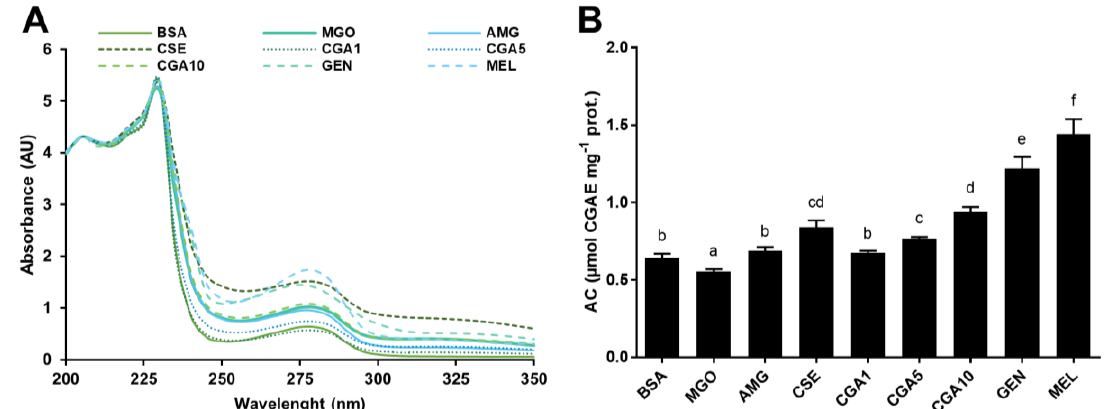
Figure 5. UV-Vis spectra ( A ) and antioxidant capacity ( B ) of the high molecular weight protein fractions (>30 kDa) isolated from the samples of the BSA-MGO glycation system (72 h agitation, 37 °C, pH 7.4) BSA: negative control; MGO: BSA + methylglyoxal; AMG: BSA + methylglyoxal + aminoguanidine; CSE: BSA + methylglyoxal + CSE (12,5 mg mL ‒1 ); CGA1: BSA + methylglyoxal + 1 mmol L ‒1 CGA; CGA5: BSA + methylglyoxal + 5 mmol L ‒1 CGA; CGA10: BSA + methylglyoxal + 10 mmol L ‒1 CGA; GEN: BSA + methylglyoxal + 5 mmol L ‒1 genistein; MEL: BSA + methylglyoxal + 5 mmol L ‒1 melatonin. Results are presented as mean ± SD ( n = 3). Bars with different letters denote significant di ff erences ( p < 0.05) when subjected to Tukey multiple range